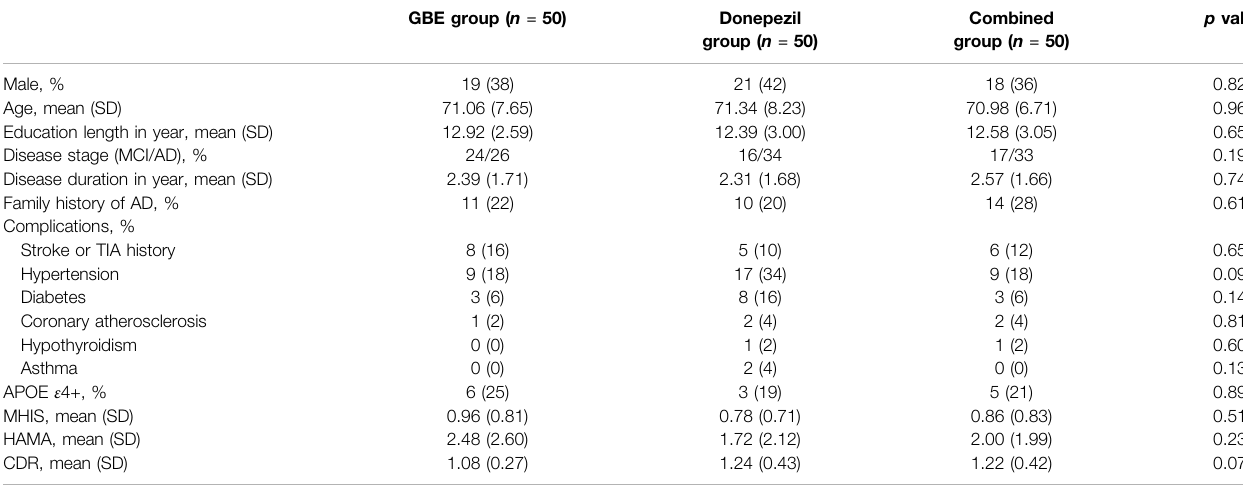
TABLE 1 | Clinical characteristics of the